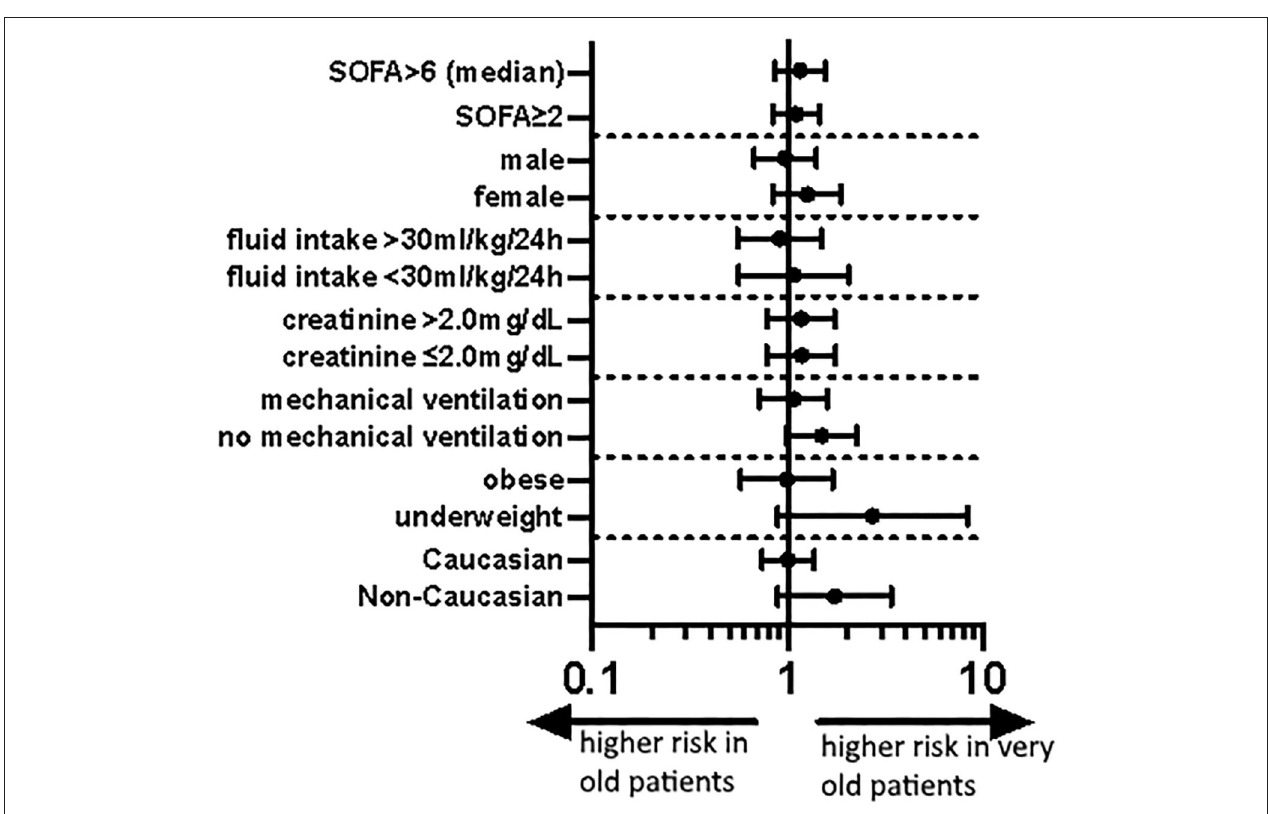
FIGURE 4 | Forest plot of aOR of old vs. very old septic shock patients for different subgroups according to model-1 (aOR 95% CI). SOFA, Sepsis-related organ failure assessment.